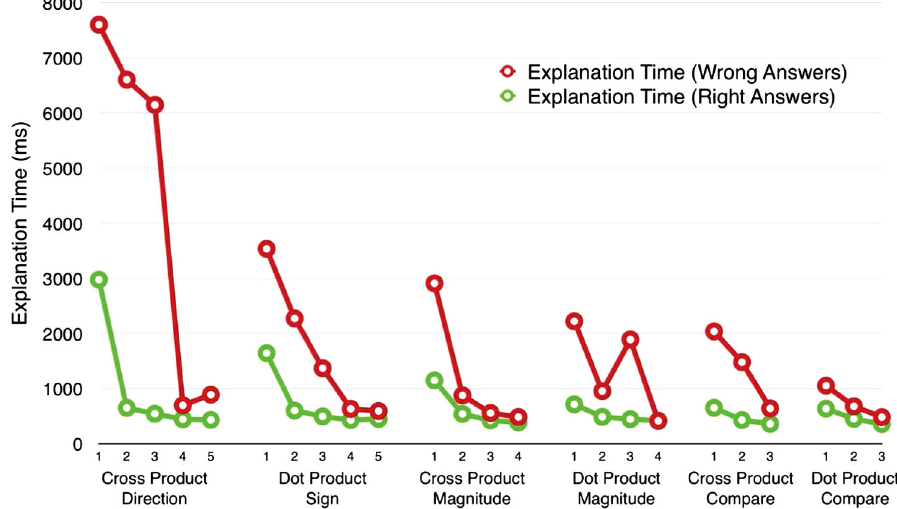
FIG. 9. Median explanation times for each training trial within a question type and for correct or incorrect responses in each